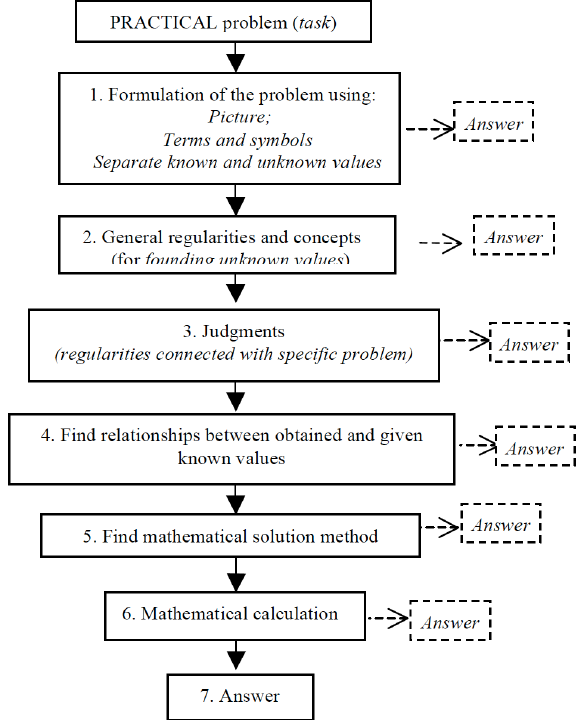
Figure 5. Frameworks for organization of practical problem solving in